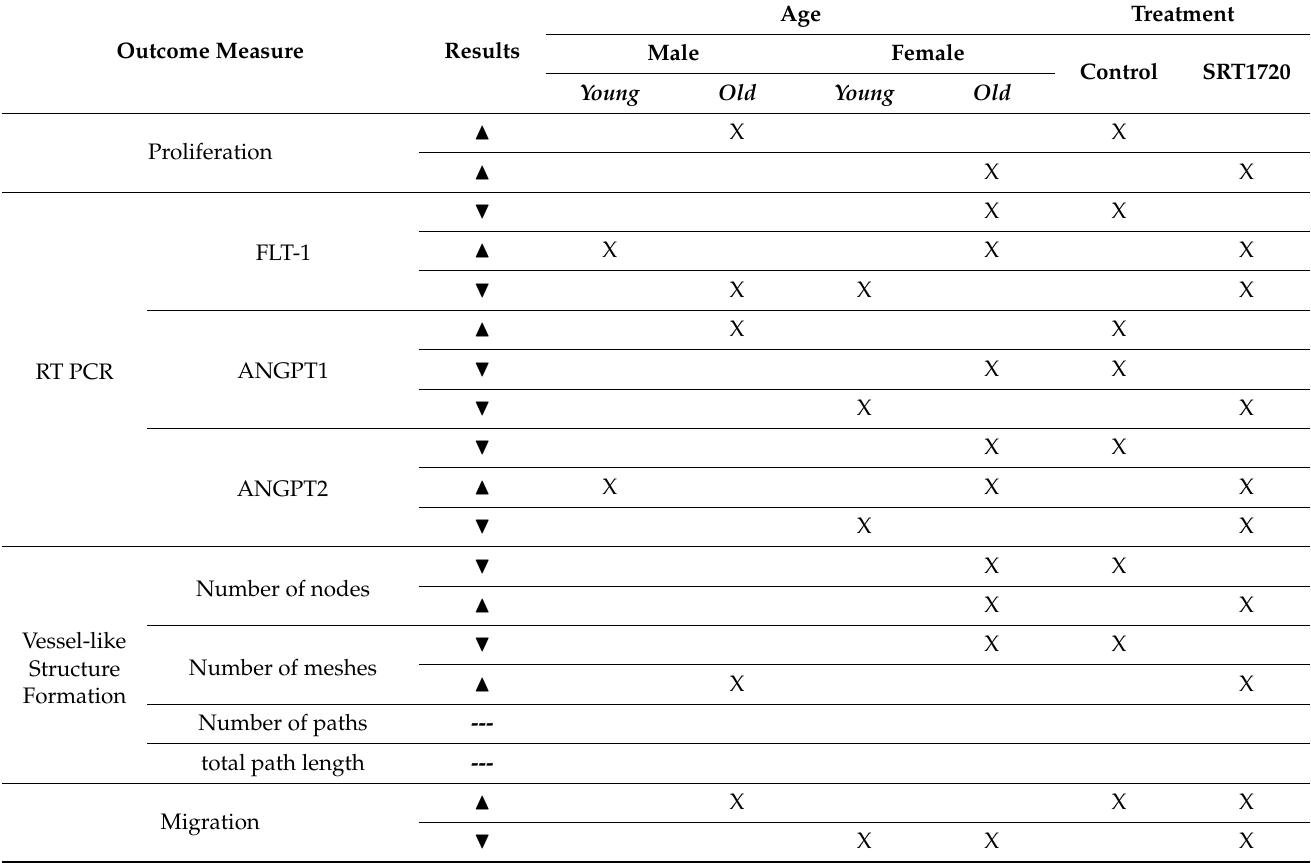
Table 2. Summary of Bone Marrow Endothelial Cell